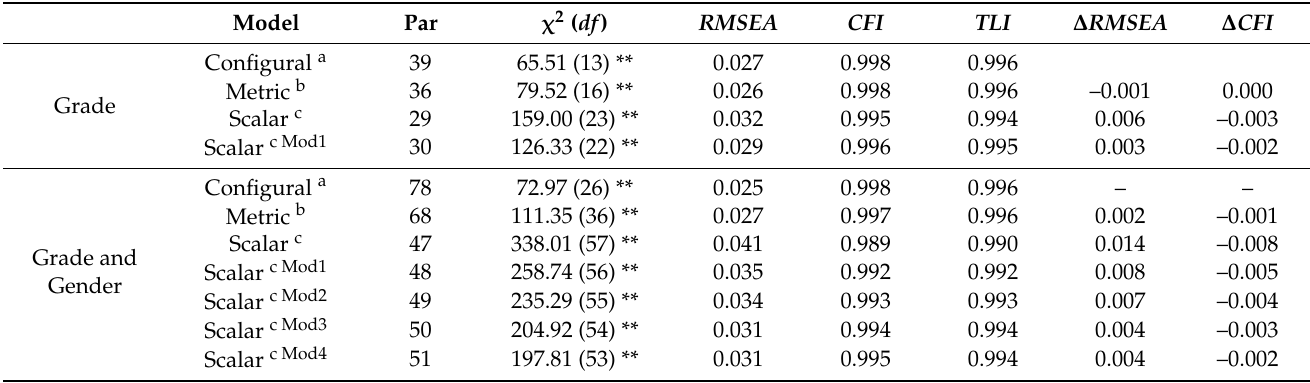
Table 3. Measures of goodness of fit of the models testing measurement invariance of PIQ-SI across time and in view of gender (simultaneously).